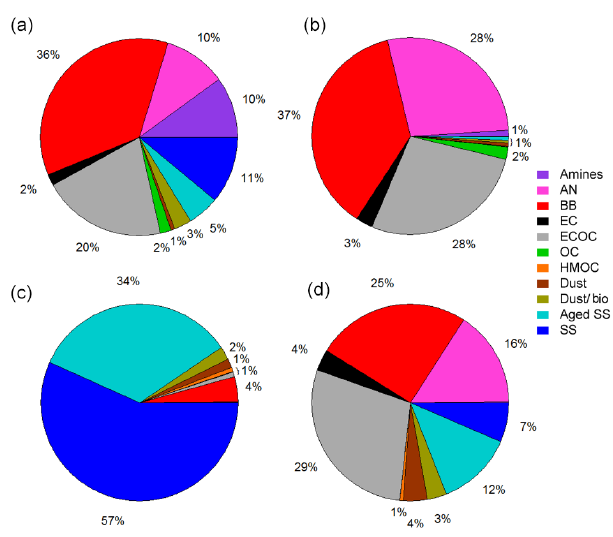
Figure 6. Pie charts for sub- (top panels) and supermicron (bottom panels) particle types for CTL (left panels) and PGF (right panels). Description of particle classifications can be found in Table 2.